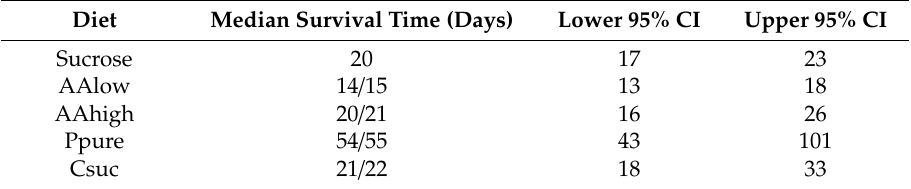
Table 2. Median survival time (in days) of bumble bees kept in micro-colonies fed di ff erent diets, including the lower and upper 95% confidence interval (CI). Days separated by a slash represent the upper and lower median. Abbreviations as follows: Pure pollen (Ppure), casein-sucrose (Csuc), only sucrose solution (60% by mass, Sucrose), 60% sucrose solution with natural concentrations of essential amino acids and proline as can be found in nectar (AAlow), and 60% sucrose solution with amino acids at a 100 times higher concentration (AAhigh). Diet Median Survival Time (Days) Lower 95% CI Upper 95% CI Sucrose 20 17 23 AAlow 14 / 15 13 18 AAhigh 20 / 21 16 26 Ppure 54 / 55 43 101 Csuc 21 / 22 18